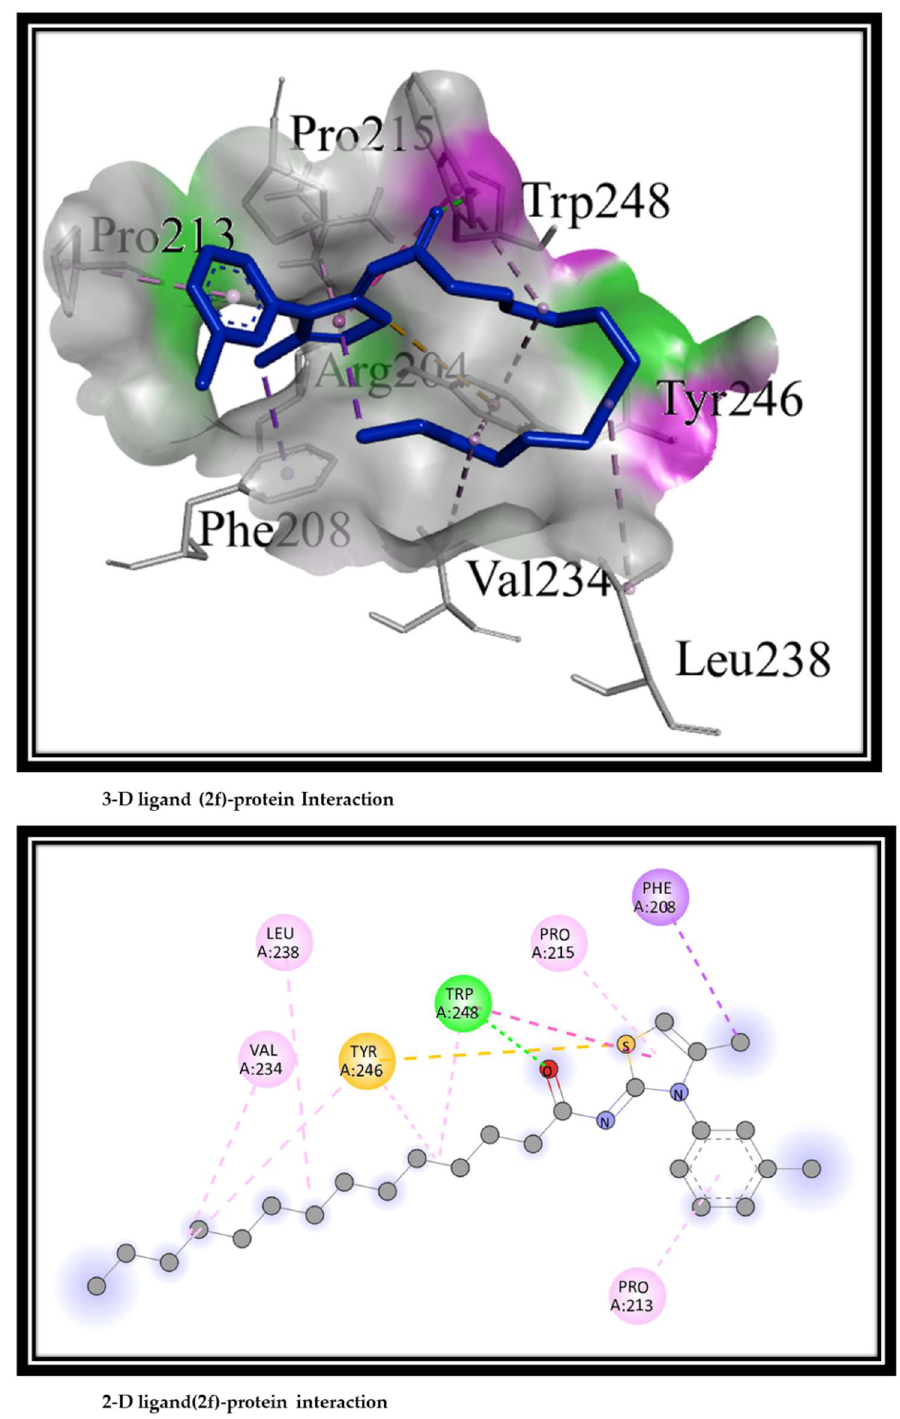
Figure 6. The 2D and 3D protein ligand ( 2f ) interactions.